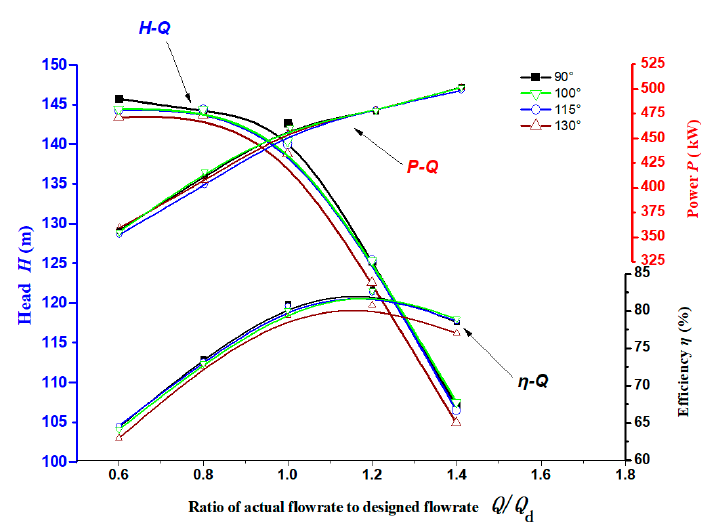
Figure 6. External performance curve of different outlet pipe angles. H-Q: Head (m)-Flowrate curve (m 3 /h); P-Q: Power (kW)-Flowrate (m 3 /h); η -Q: Efficiency (%)-Flowrate (m 3 /h).